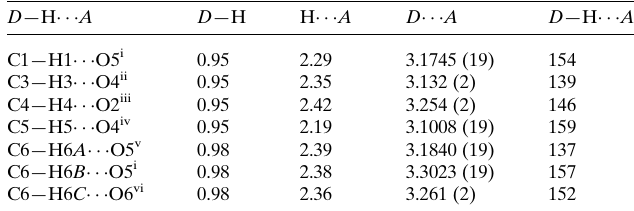
Table 1 Hydrogen-bond geometry (A˚ , (cid:4) ).